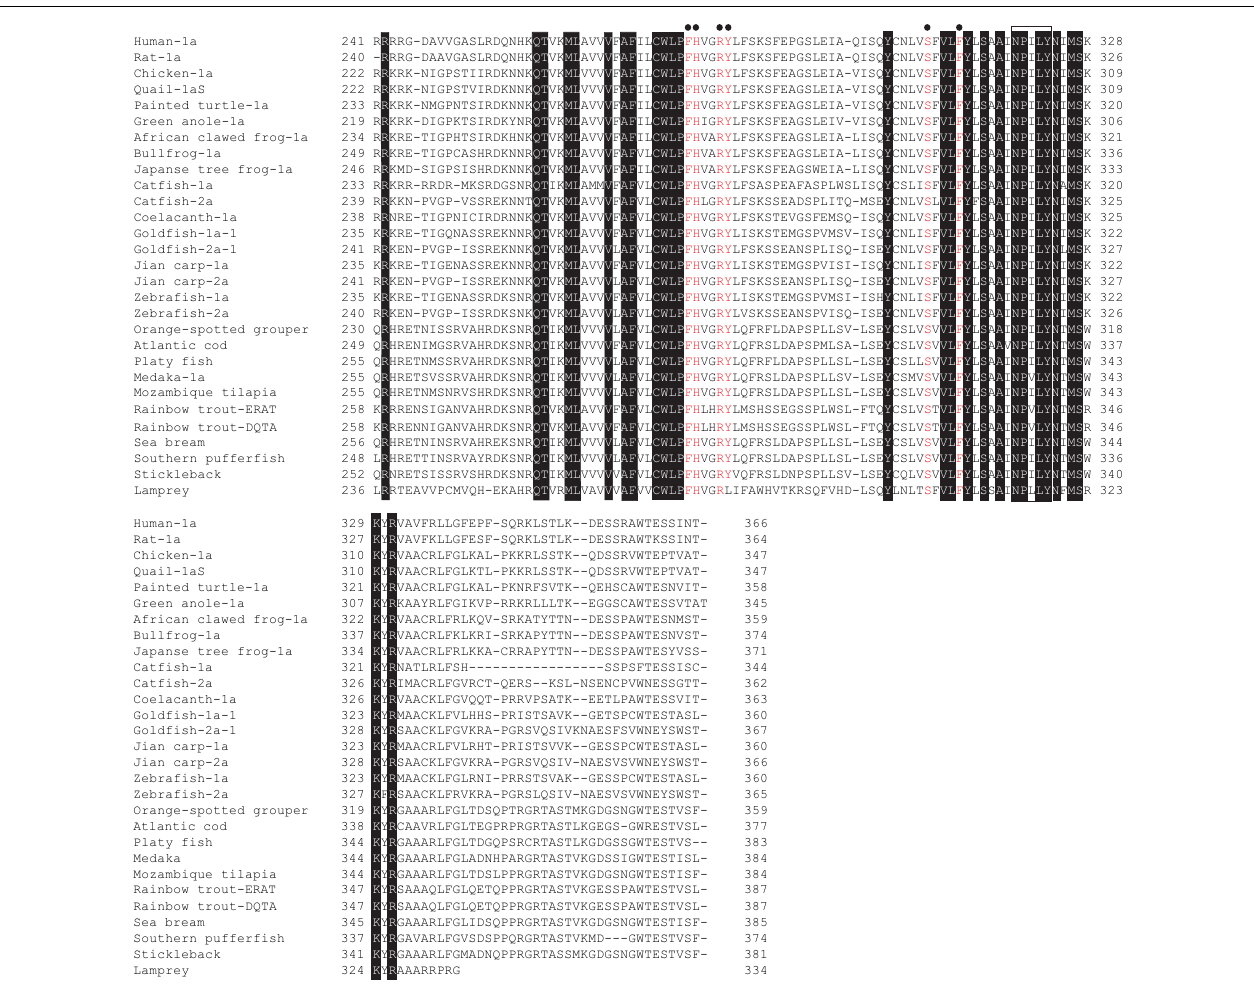
FIGURE 3 | GHS-R1a, 2a and GHS-R1a-LR proteins in non-mammalian vertebrates . Dense shading indicates common amino acids (AAs) in all species. Red letters under black circles represent specific AAs related to ligand binding, selectivity, and constitutive activity of GHS-R1a and 2a. Boxes show the typical motifs of the G-protein-coupled receptor transmembrane domains 5 and 7. Sequences were aligned using GENETYX-Mac version 15.0.1.